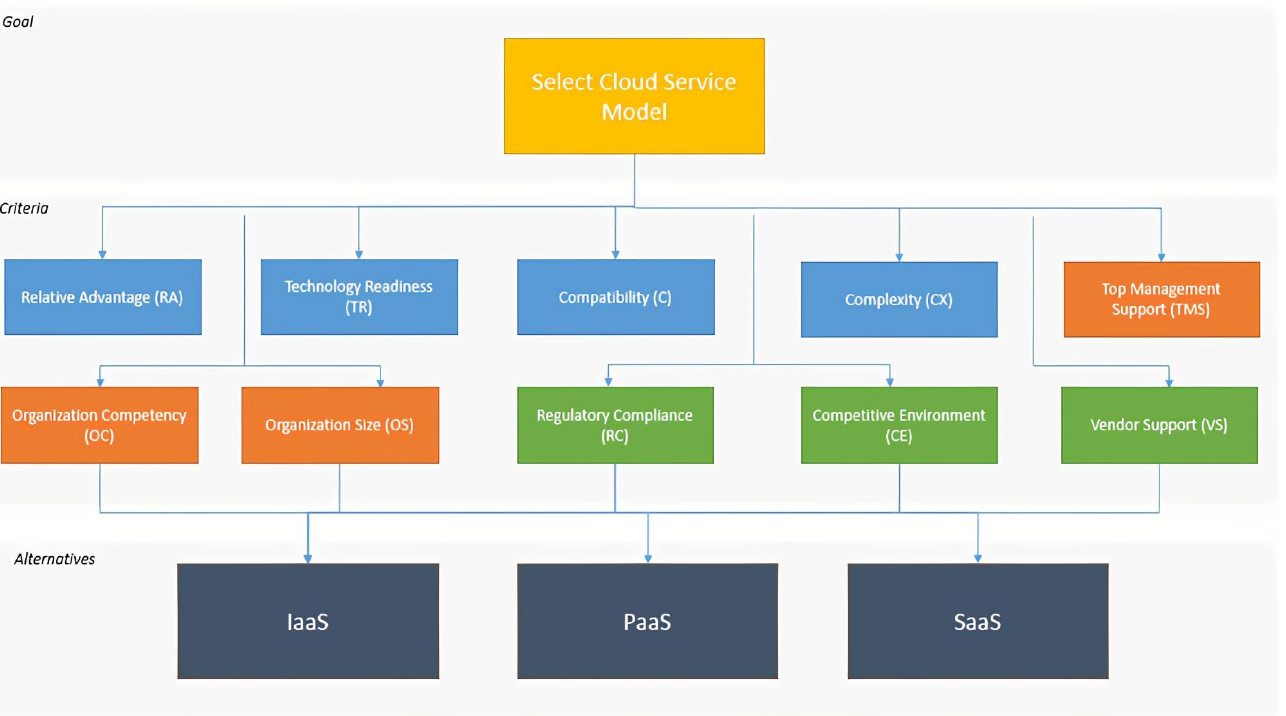
Figure 12. Cloud service model.